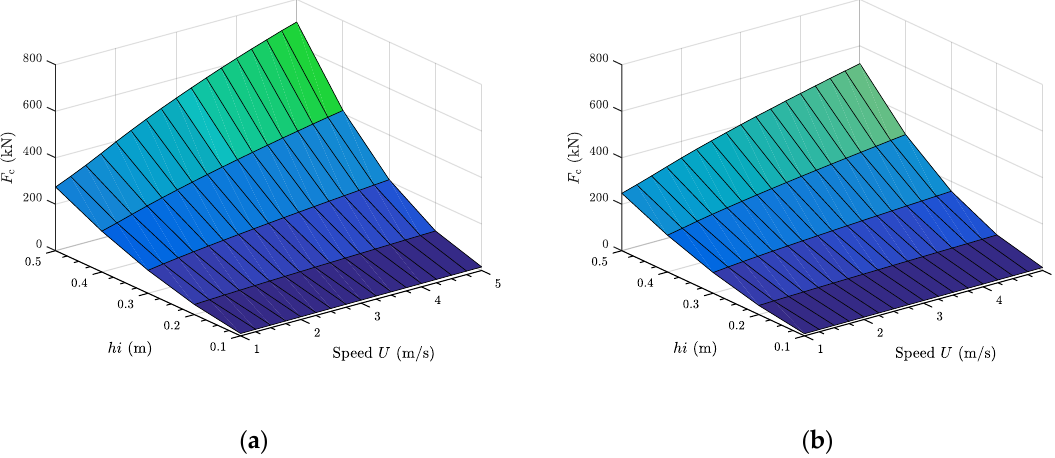
Figure 20. Ice critical force ( F C ) in terms of ship speed and ice thickness for stem angle 25 ◦ . ( a ) Ship stem collision; ( b ) Ship shoulder collision.